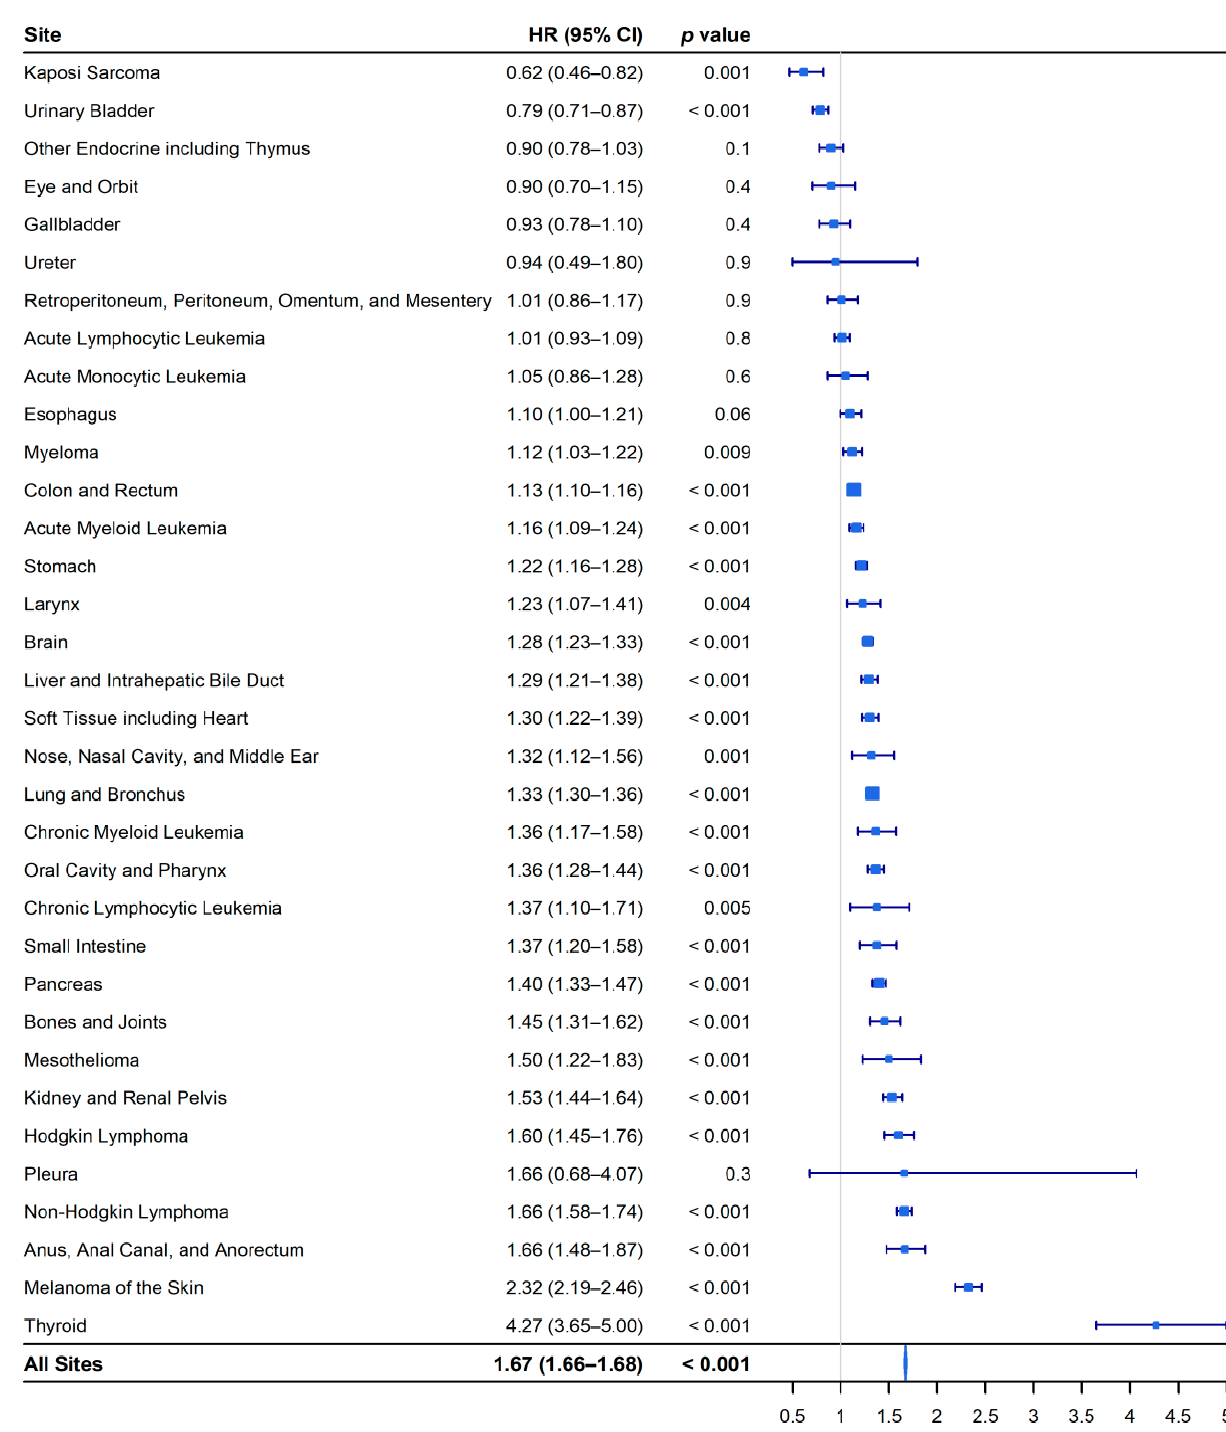
Figure 5. Forest plot of the site-specific hazard ratios of cancer-specific death for male and female adolescents and young adults (15–49 years). Female adolescents and young adults are the reference group. The all-site hazard of cancer-specific death was 1% higher in older adult men than in older adult women (HR, 1.01; 95% CI, 1.00 to 1.01; p < 0.001). Older adult women had a